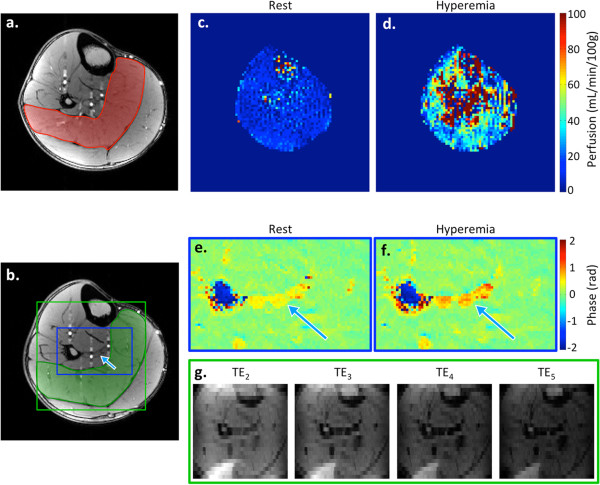
Example images from a representative young healthy subject. High-resolution scout images located at isocenter (a) and 3 cm inferior (b), corresponding to the PASL and multi-echo GRE slice locations, respectively. The soleus is indicated in red (a) and green (b), and the blue arrow points to the peroneal vein. Perfusion images represent baseline (c) and peak hyperemic flow (d). Phase images are shown for baseline (e) and the washout time (f). Note the increased phase accrual in the three veins at washout time, corresponding to a decrease in SvO2. The blue arrow identifies the peroneal vein that was used for dynamic SvO2 analysis. Multi-echo GRE magnitude images for each of the echo times used to quantify T2* are shown in (g).